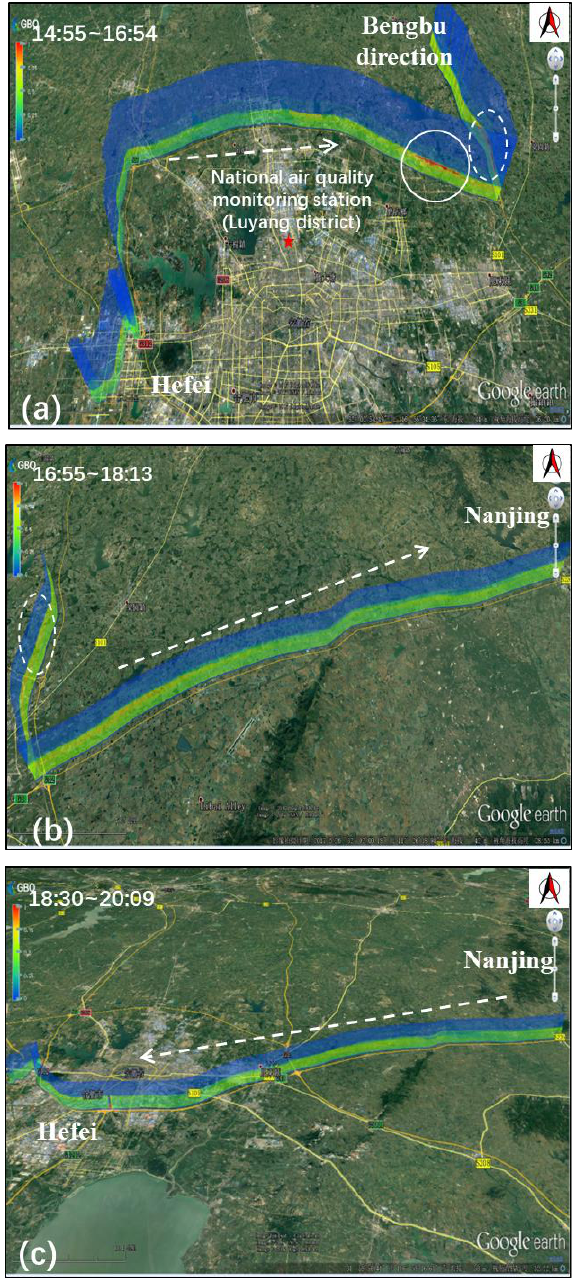
Fig. 4 Mobile lidar observation